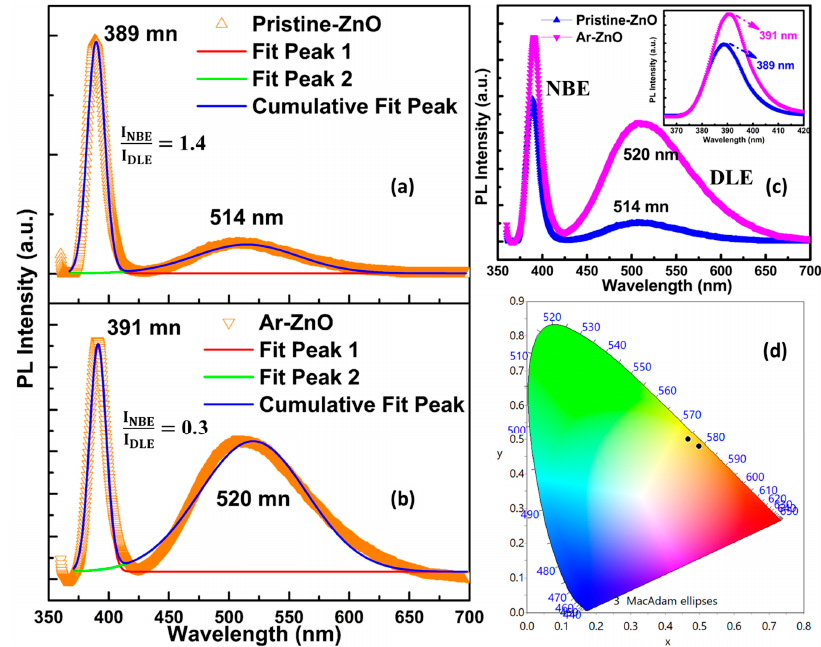
Figure 5. ( a , b ) Fitted PL spectra of pristine ZnO and Ar-ZnO nanowires, respectively, along with the ratio of NBE to DLE; ( c ) Comparative display of pristine ZnO and Ar-ZnO spectra; and ( d ) CIE 1931 chromaticity diagram showing the color of emitted light.